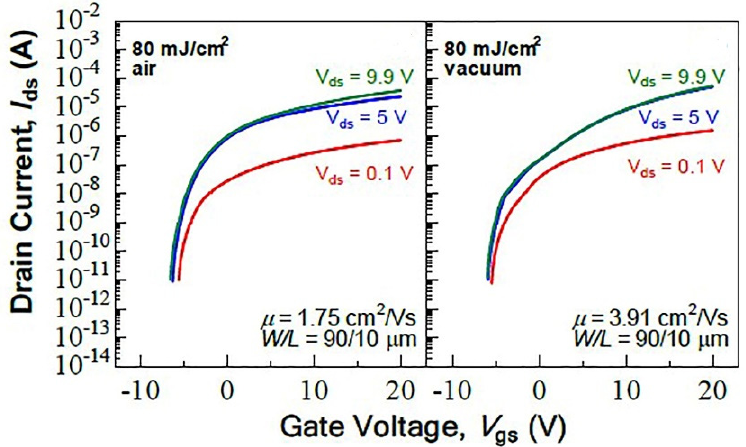
Figure 9. Performance of IZO-TFT devices treated by laser in different atmospheres [43].